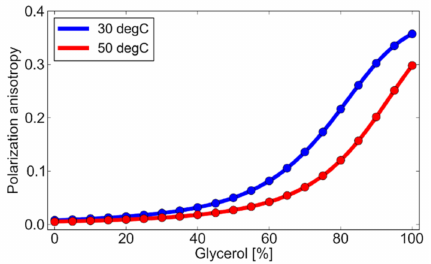
Figure 4. Fluorescence anisotropy of fluorescein solution as a function of a solution’s viscosity.